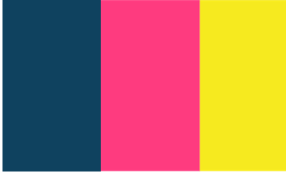
Figure 13. Color after visualization. The Pop art style color extracted above is assigned to two different connected domains (foreground and background) separated by binarization. The resulting Yangliuqing New Year prints image has a distinct Pop art style. Shown in Figure 14.